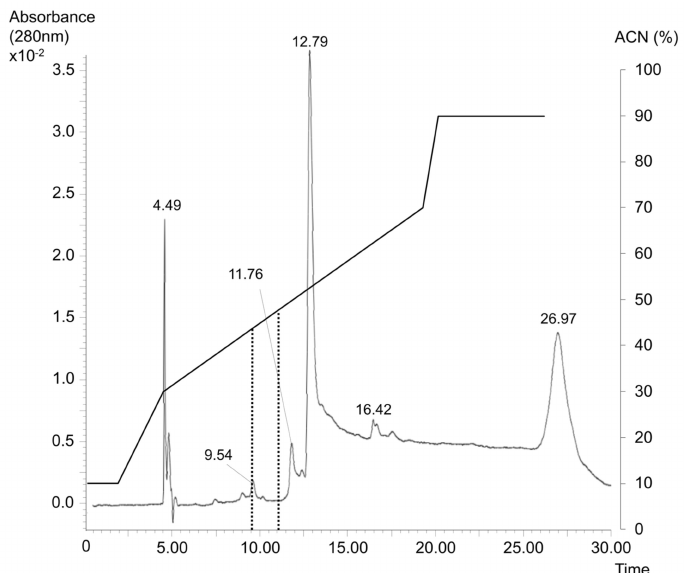
Figure 4. Chromatogram from high performance liquid chromatography (HPLC) of recombinant high mobility group box 1 (HMGB1) spiked in plasma. The gradient of acetonitrile (ACN) is overlaying the chromatogram. The fraction from 9.5–11 min, where HMGB1 is eluted, is